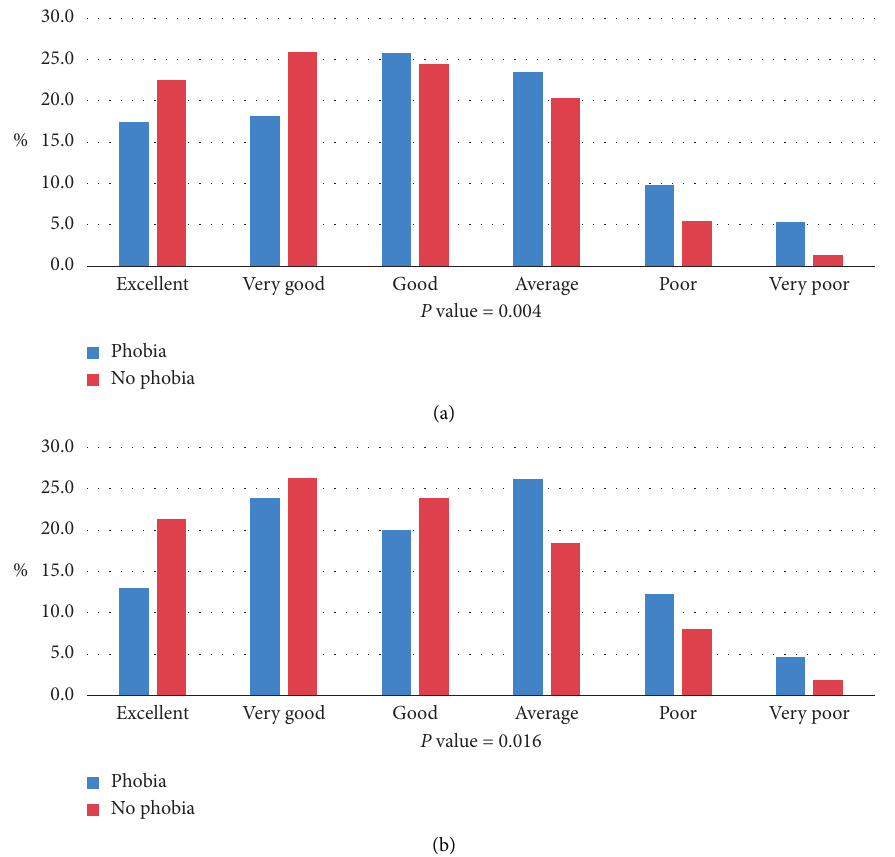
Figure 1: Self-perceived oral health among pregnant women with and without dental phobia. (a) Perception about health of teeth among pregnant women with and without dental phobia. (b) Perception about health of gums among pregnant women with and without dental phobia.